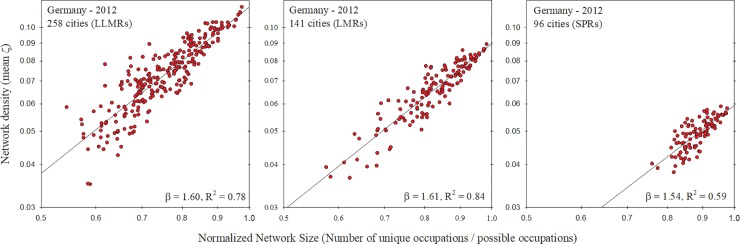
Occupational network size vs. density for German cities at different spatial aggregation levels.When the size of an occupational network is compared to its density, the resulting scaling exponents differed little when German employment is geographically aggregated into 258 LLMRs, 141 LMRs, or 96 SPRs. Note that, for comparability, network size has been normalized by maximum possible size.